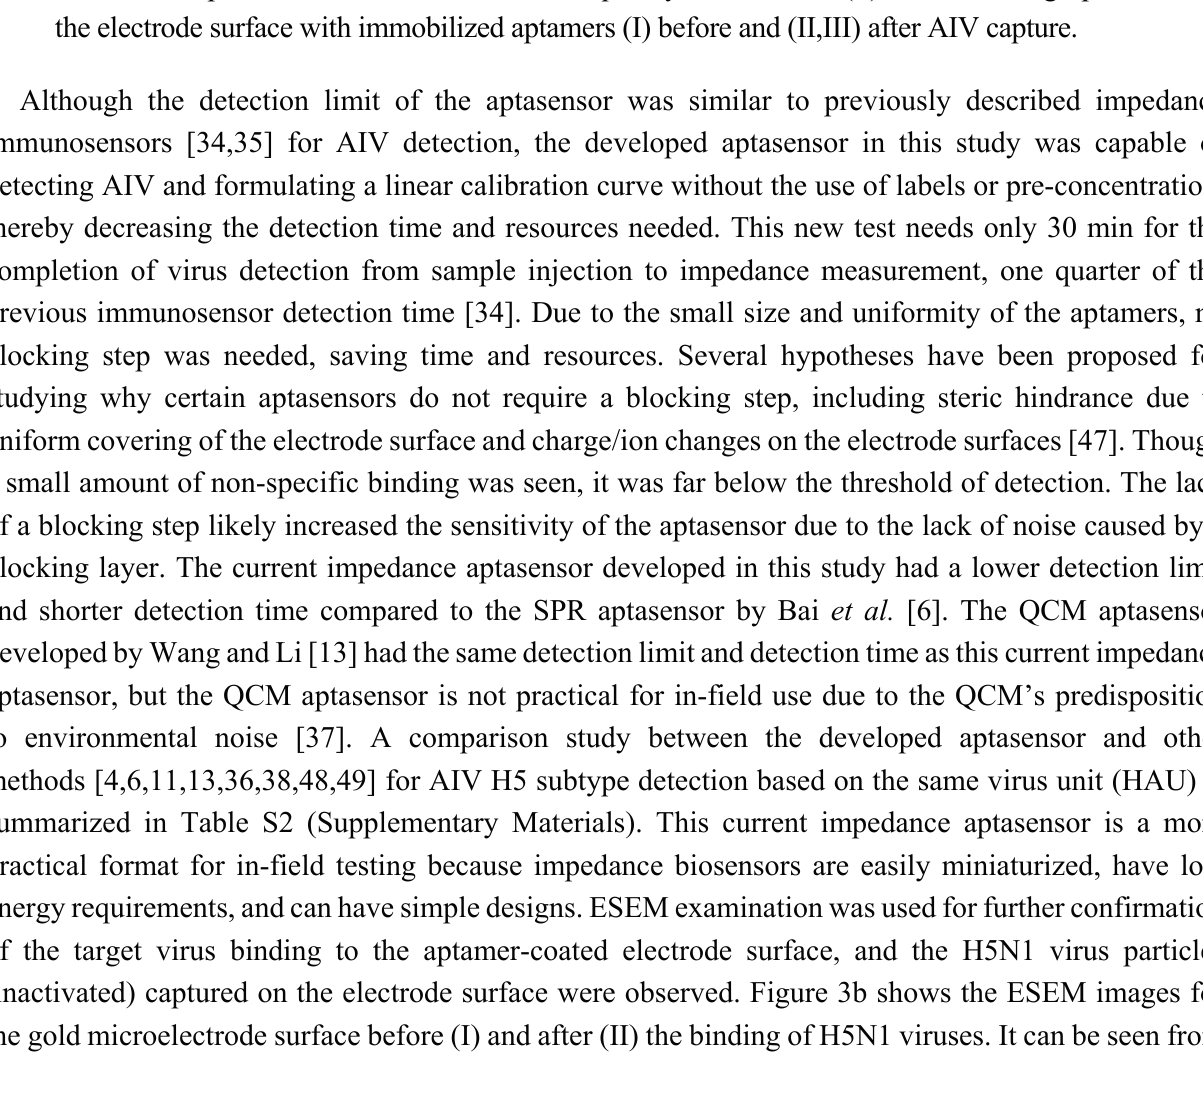
Figure 3. ( a ) Average impedance change caused by different concentrations of AIV H5N1. The values of the horizontal axis correspond to serial dilution values of 128 HAU virus sample (12.8–0.00128 HAU). Error bars are based on the standard deviation of triplicate tests. The impedance was measured at the frequency of 25.8 kHz; ( b ) ESEM micrographs